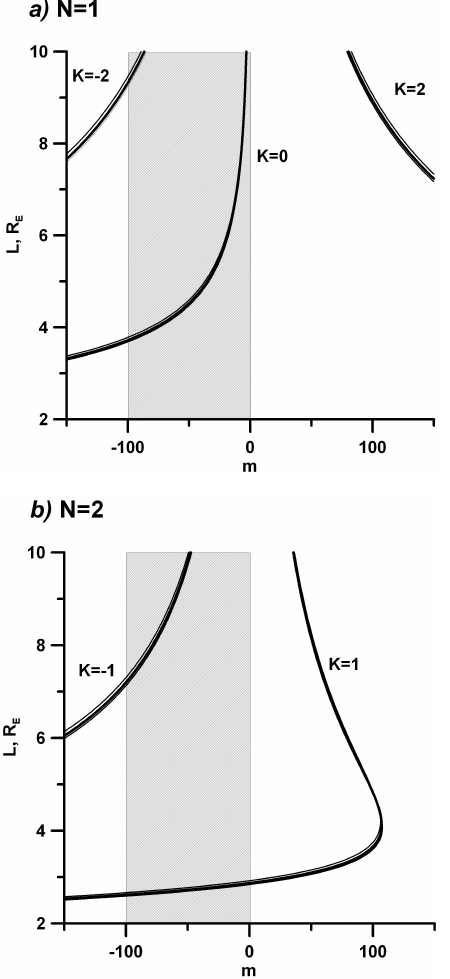
plane for various K and (cid:15) ∼ 150keV: (a) N = 1 case, (b) N = 2 case. maximalvalue. Shadedareasshowregionsofthemosteffectiveinstabilityforthespatiallyinhomogeneousdistribution. Thesolidhorizontal L − m plane for (cid:15) ∼ 10keV: (a) for K = 0 and N = 1, (b) for K = 1 and value. The shaded region corresponds to the observed values of azimuthal wave numbers − 100 < m < 0 .